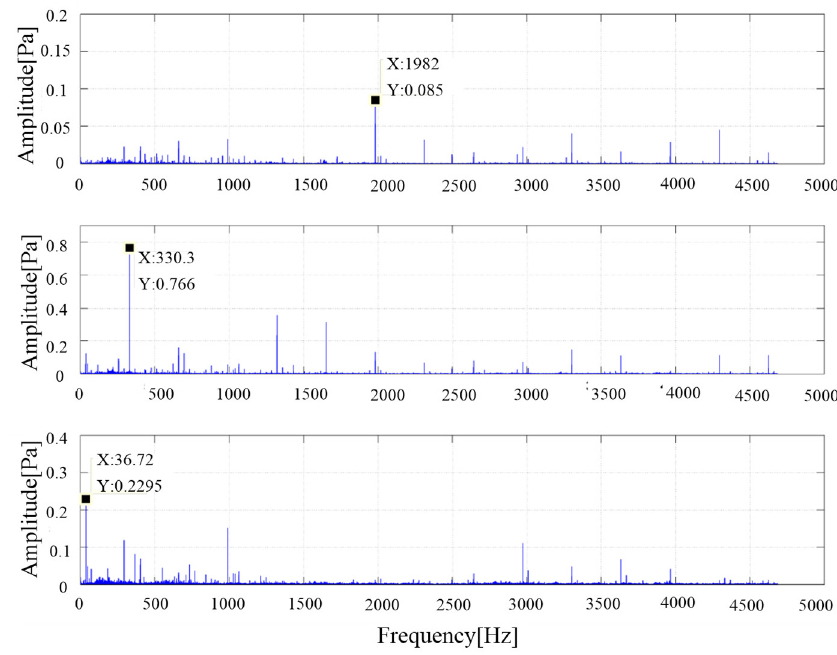
Figure 9. Results of noise separation of the test rig of the original gear pump.